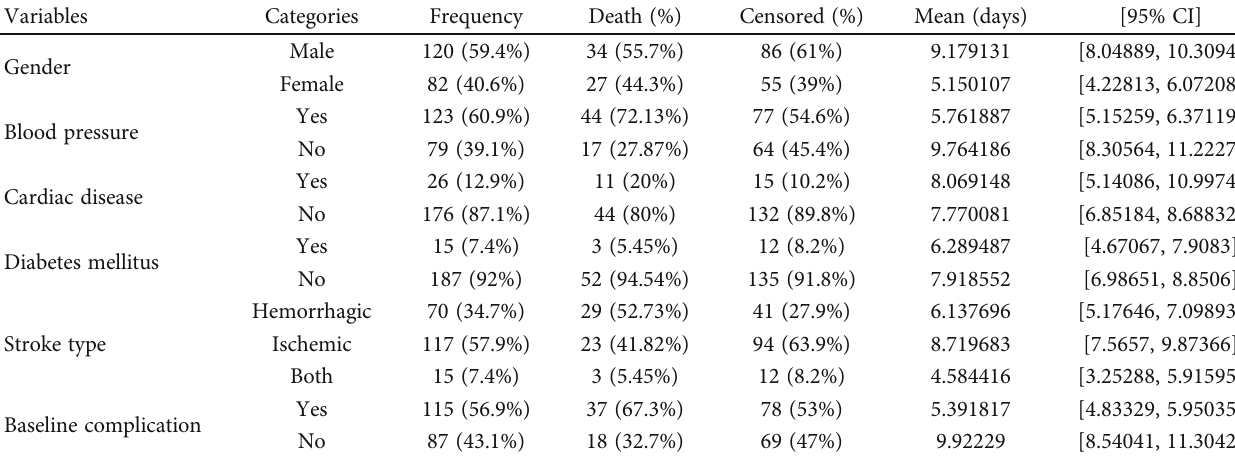
Table 1: Baseline covariate characteristics with their time-to-death status.